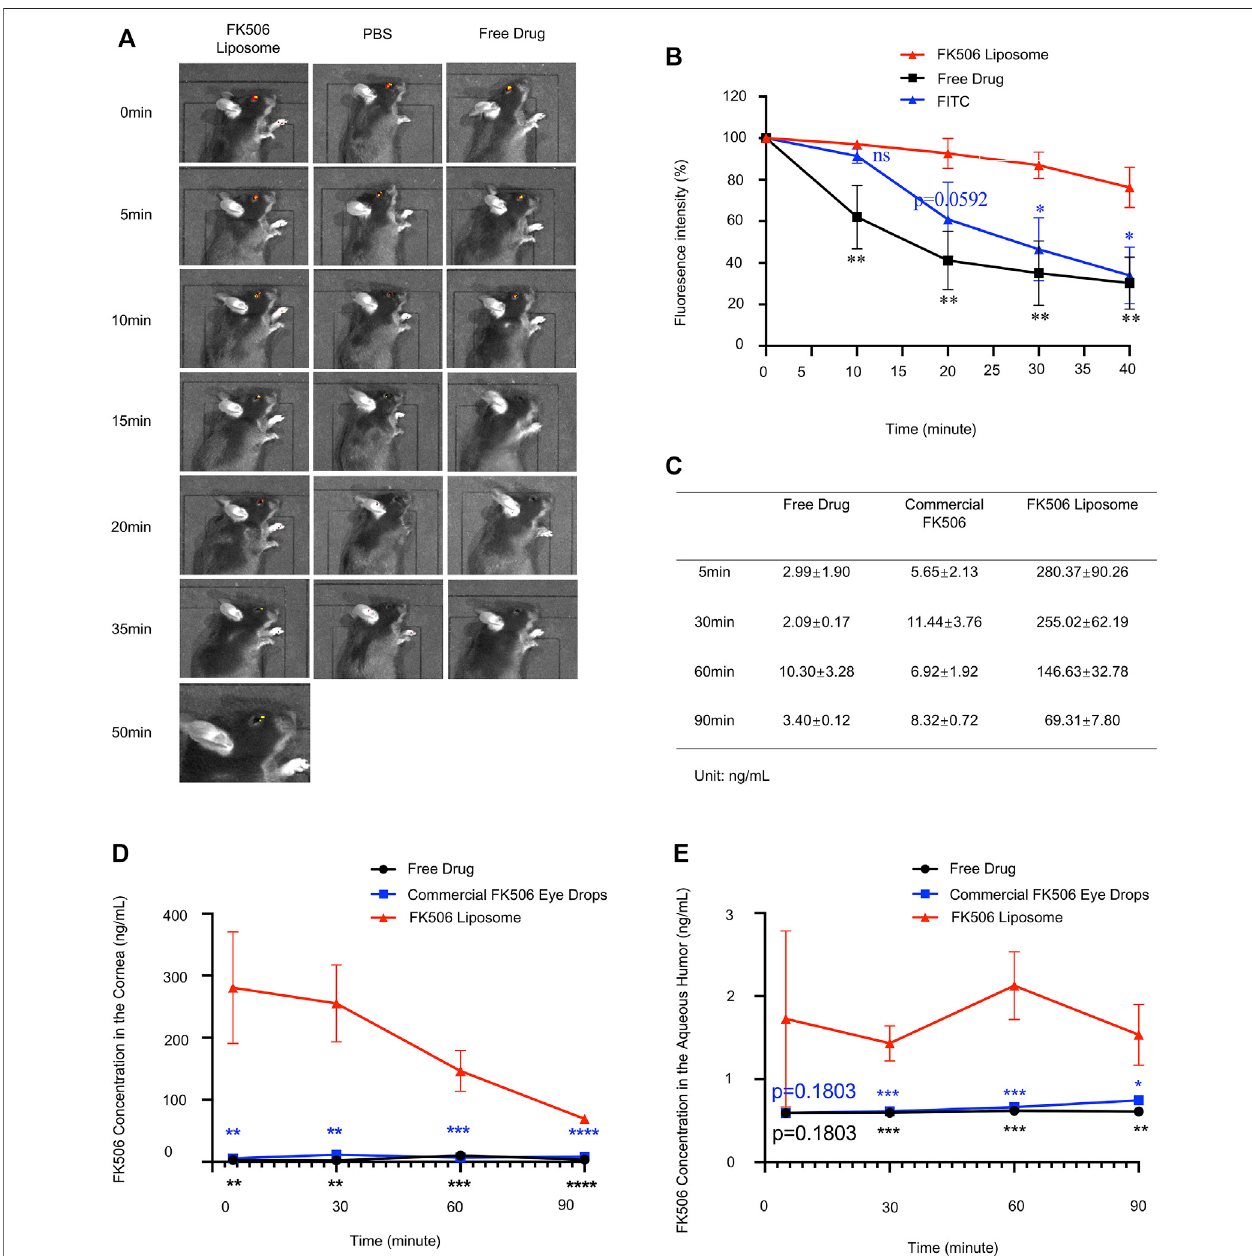
FIGURE 4 | (A) After instilling three different preparations for 0, 5, 10, 15, 20, 35, and 50 min, the fl uorescence intensity on the ocular surface. (B) Fluorescence intensity variation curve of different treatment groups tracked by IVIS at different time intervals ( n (cid:2) 3). (C) FK506 concentration in the rabbit corneas after using different FK506 preparations at different time intervals ( n (cid:2) 3). (D) Corneal FK506 concentration-time curve ( n (cid:2) 3); (E) FK506 concentration intheaqueoushumor ofrabbits after using different FK506 preparations at different time intervals ( n (cid:2) 3). The data was presented as mean ± SD, one-way ANOVA, * p < 0.05, ** p < 0.01, *** p < 0.001, and **** p < 0.0001; ns denotes no signi fi